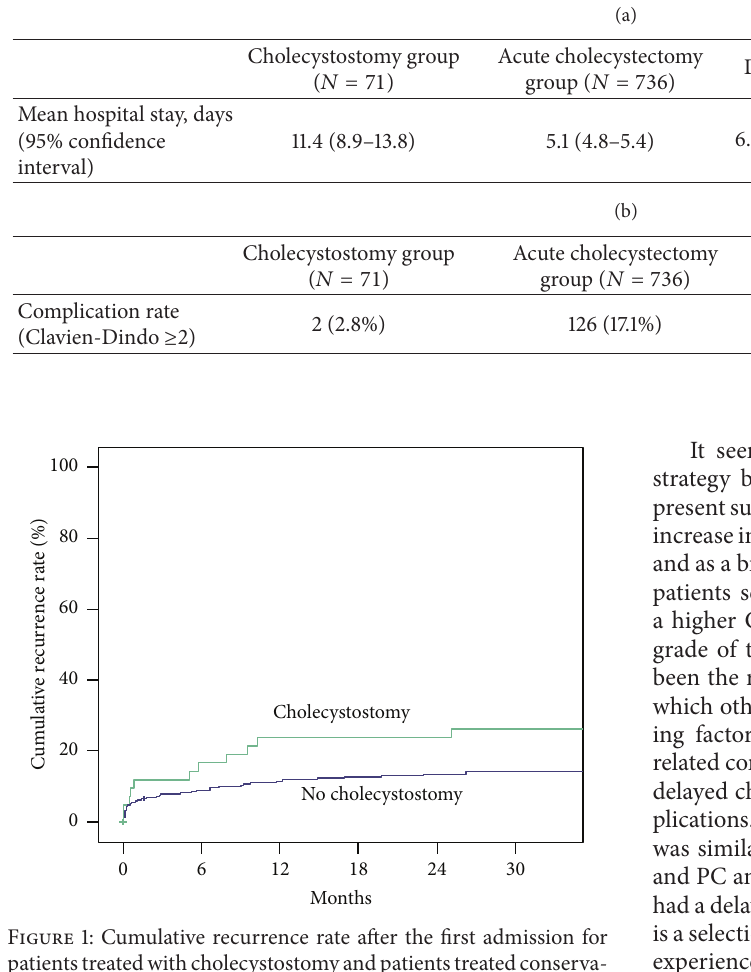
Table 2: (a) Hospital stay in the cholecystostomy and acute cholecystectomy groups. Multivariate linear regression analysis was performed with adjustment for age, gender, Charlson comorbidity index, and degree of cholecystitis. (b) Complication rate in the cholecystostomy and acute cholecystectomy groups. Multivariate logistic regression analysis was performed with adjustment for age, gender, Charlson comorbidity index, and degree of cholecystitis.